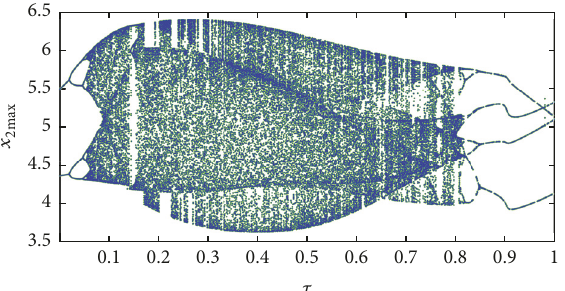
Figure 5: Chaotic attractor of the time delayed nonautonomous HPS.